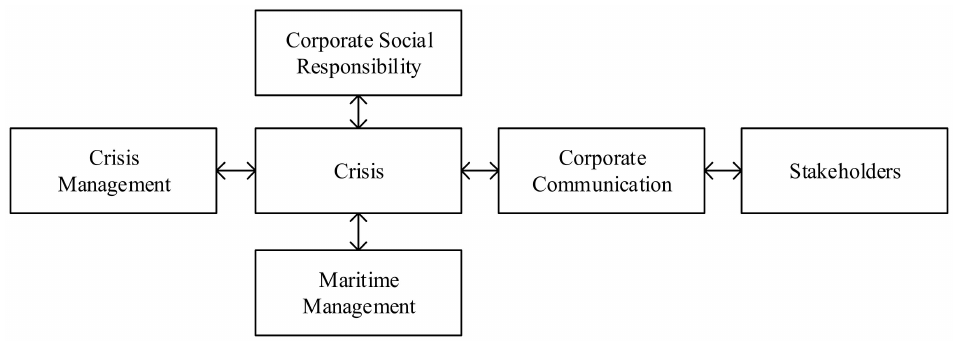
Figure 1. Integrated theoretical